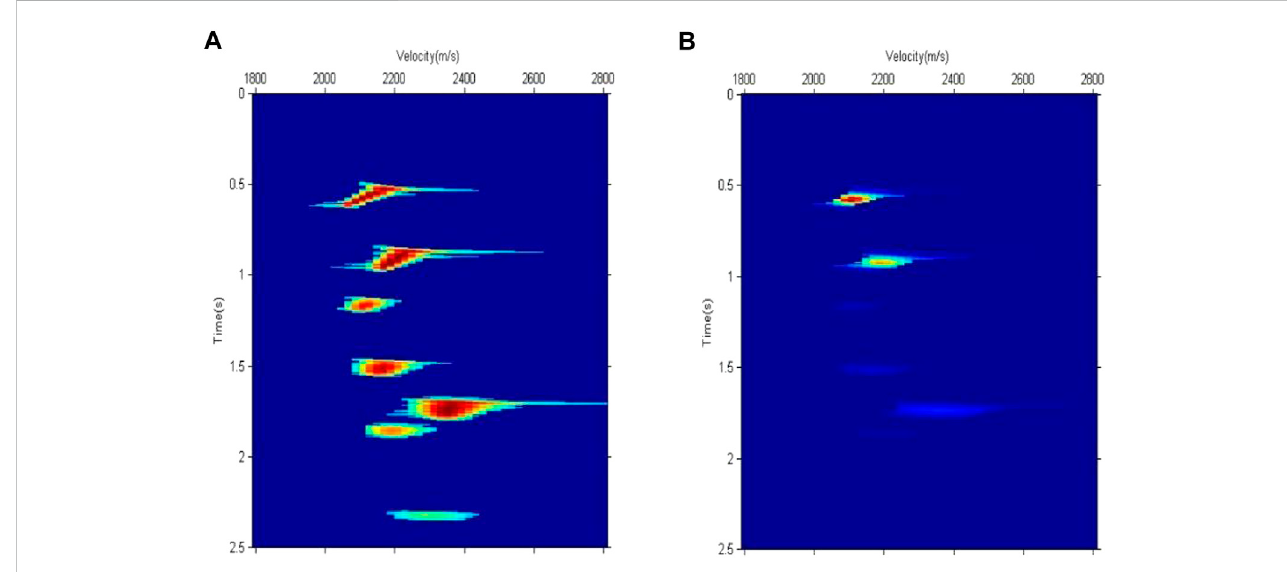
FIGURE 6 (A) Calculation area of the semblance velocity spectrum. (B) Calculation area of the average amplitude